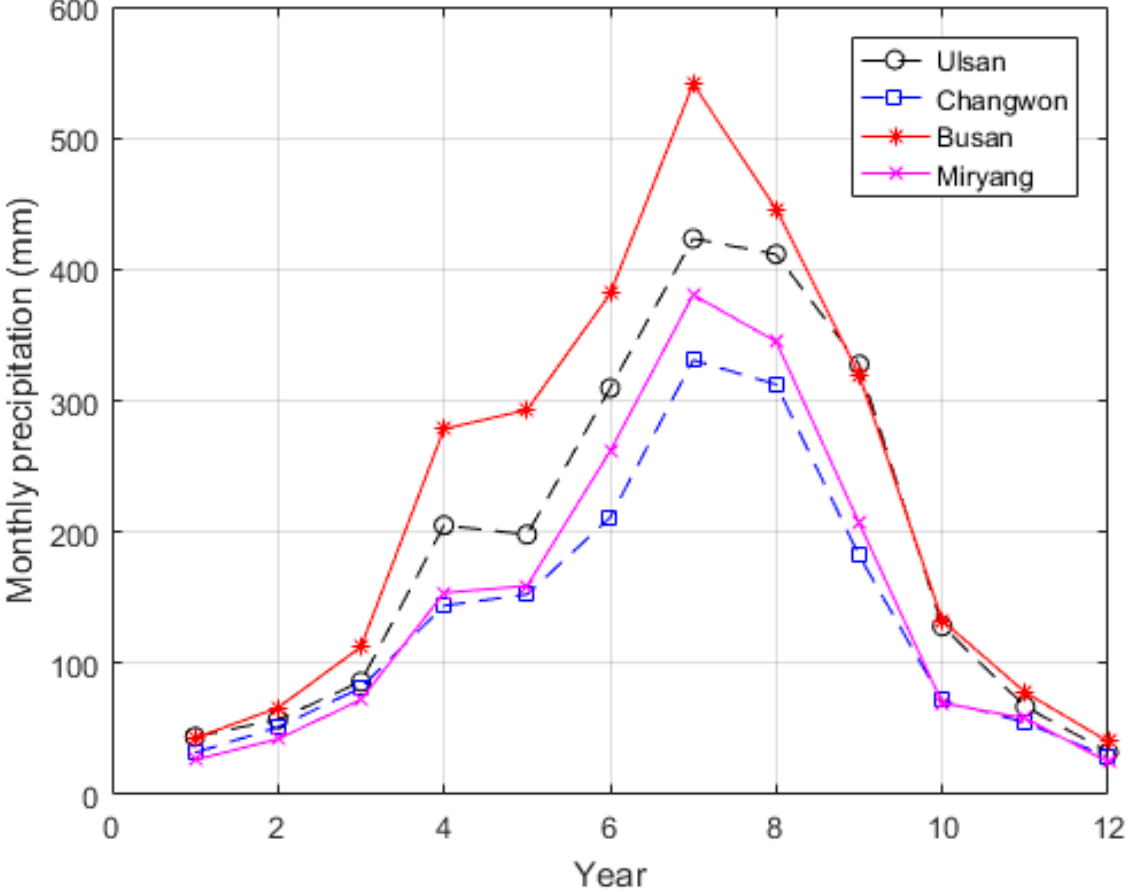
Figure 2. Monthly rainfall of 30-year average (1981–2010) in the study area.